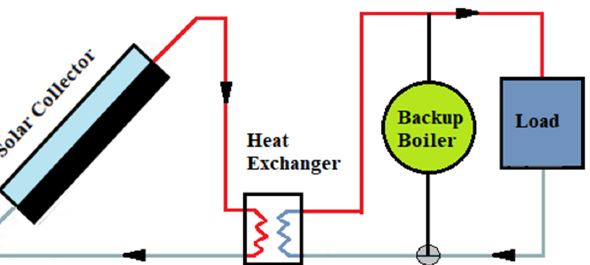
Figure 6. Indirect steam generation system with unfired boiler containing the backup. Adapted from Ref. [44], Copyright (1985), with permission from Elsevier.